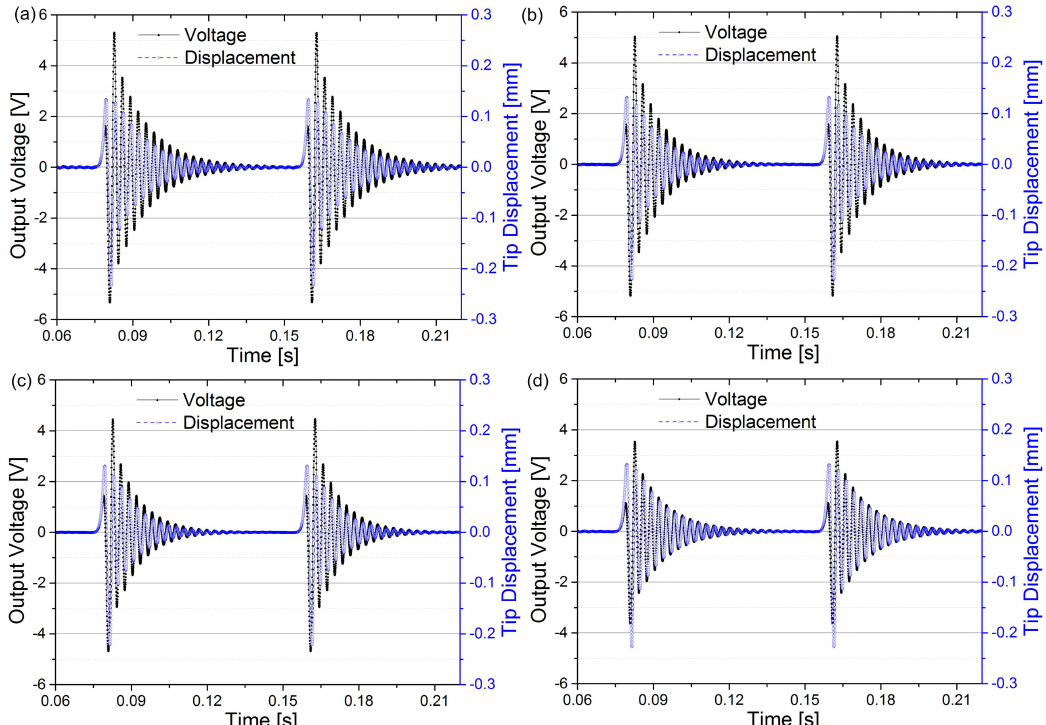
Figure 6. The variation of beam tip displacement and output voltage for different electrode coverage ratios with their optimal resistive loads connected. ( a ) 32.1% (235 k Ω ); ( b ) 43.4% (185 k Ω ); ( c ) 66.1% (135 k Ω ) and ( d ) 100% (95 k Ω ). The driving magnet rotates at 12.5